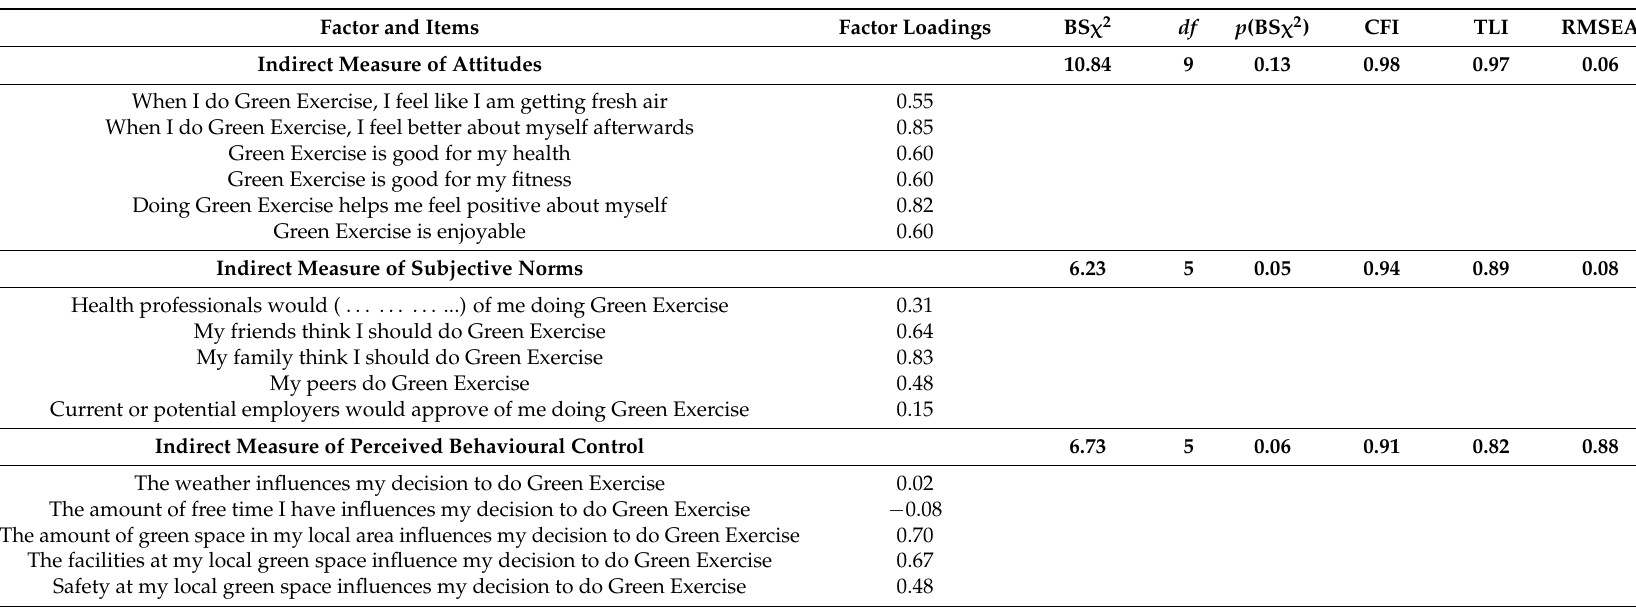
Table 3. Fit statistics for two-factor and three-factor model of the indirect beliefs about green exercise (BAGE-ID). Factor BS χ 2 df p (BS χ 2 ) CFI TLI RMSEA Attitudes × Subjective Norms 28.83 26 0.03 0.96 0.95 0.06 Attitudes × Perceived Behavioural Control 32.60 26 0.00 0.93 0.90 0.09 Subjective Norms × Perceived Behavioural Control 7.55 8 0.15 0.98 0.97 0.04 Three-factors 44.91 41 0.09 0.97 0.96